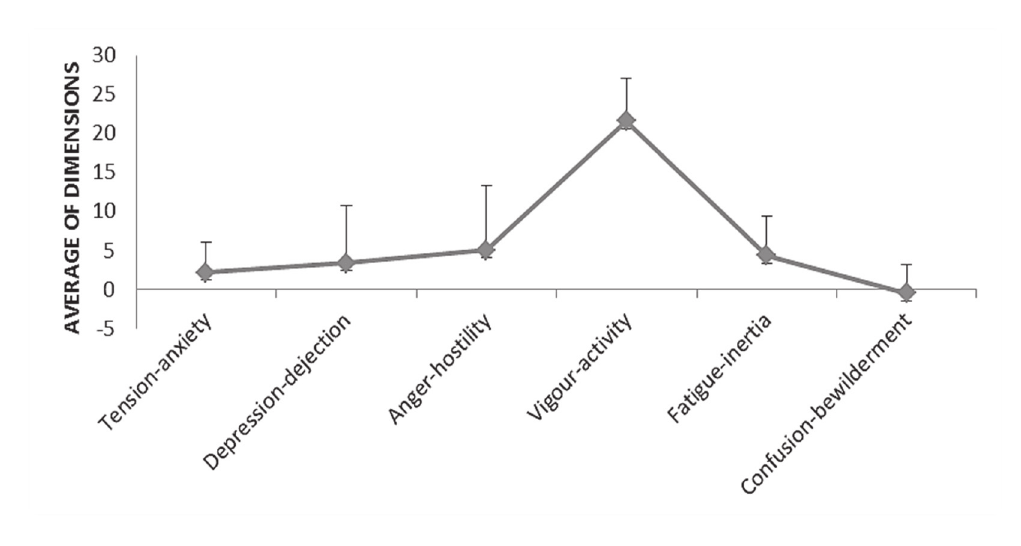
Figure 1. Average and standard deviation of the dimensions assessed in the POMS